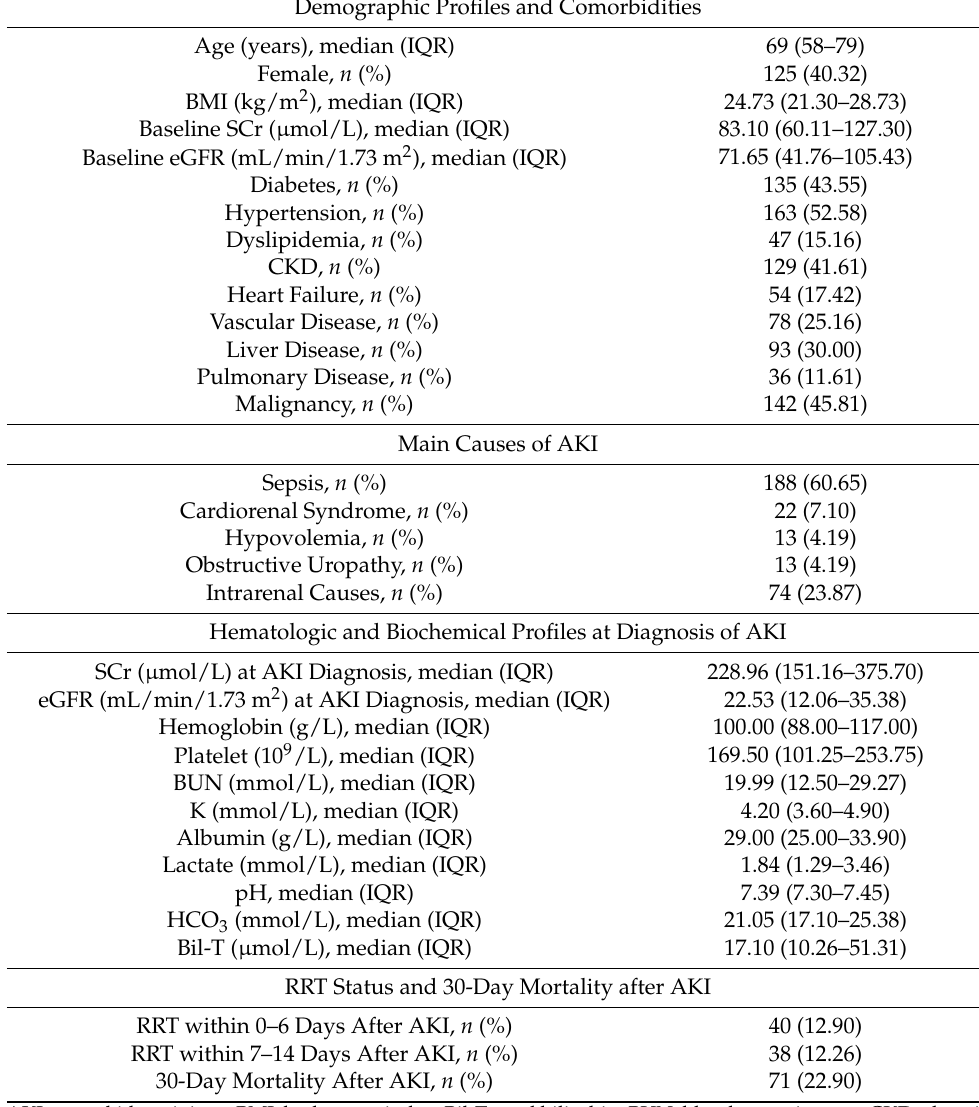
Table 1. Characteristics of patients with AKI ( n =